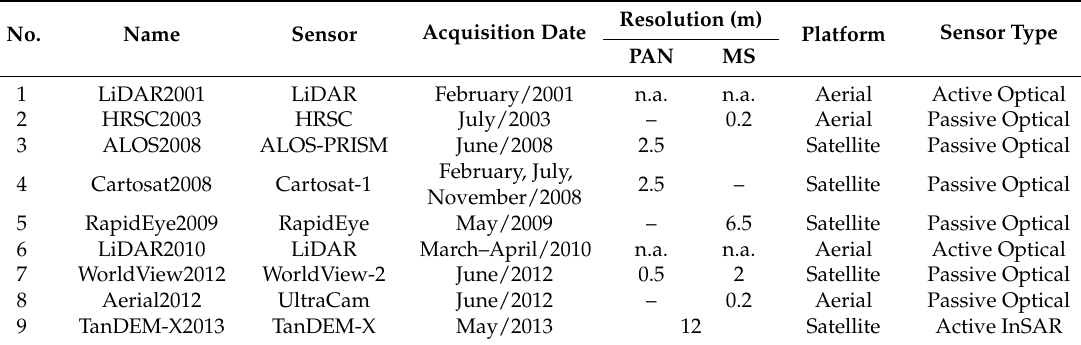
Table 1. Summary of the remote sensing